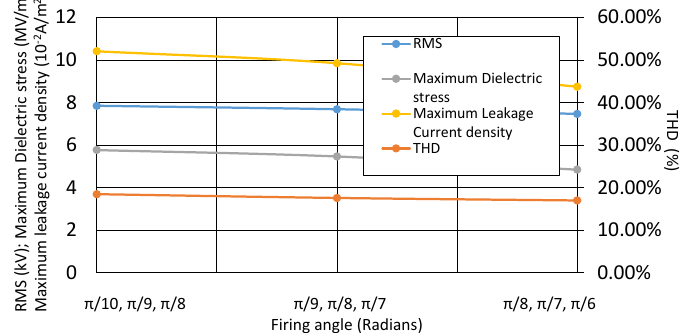
Figure 13. Effect of increasing firing angle in a 7-level inverter. Left Vertical axis: RMS in kV; Maxi- mum Dielectric stress in MV/m; Maximum leakage current density in 10 − 2 A/m 2 ; Right Vertical axis: THD in %.